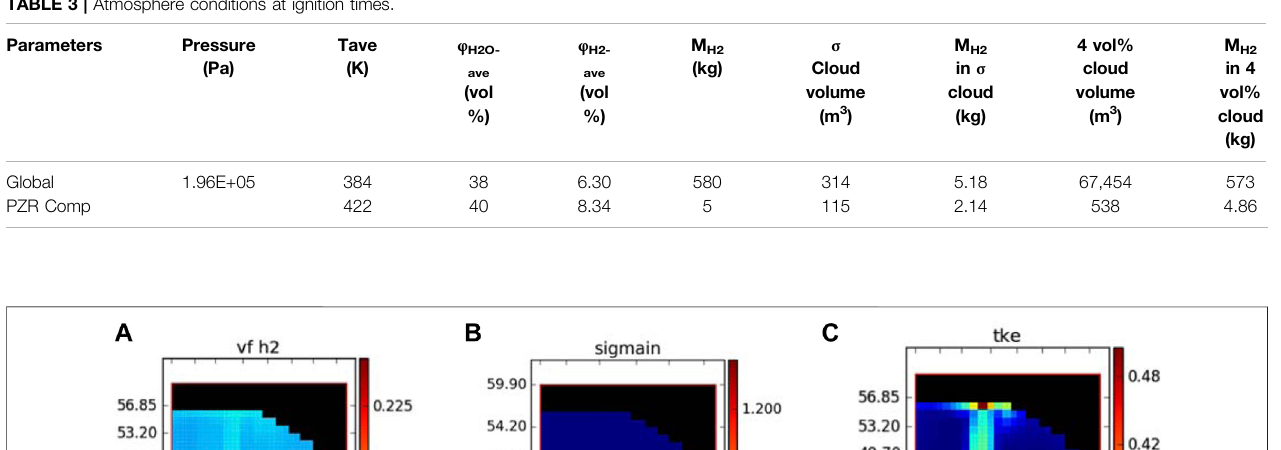
TABLE 3 | Atmosphere conditions at ignition times.